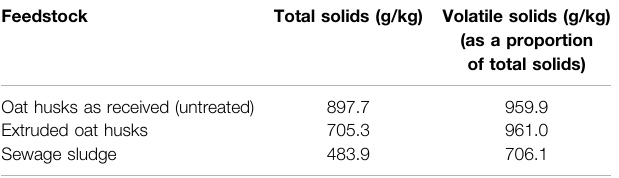
TABLE 1 | Compositional analyzes of oat husks as received (untreated) and following the BioExtruder pre-treatment technology. Feedstock Total solids (g/kg) Volatile solids (g/kg)